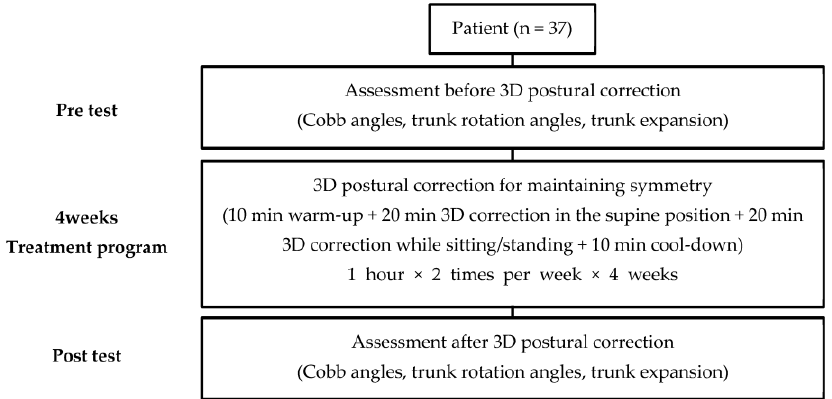
Figure 2. Ultrasound imaging measurement.